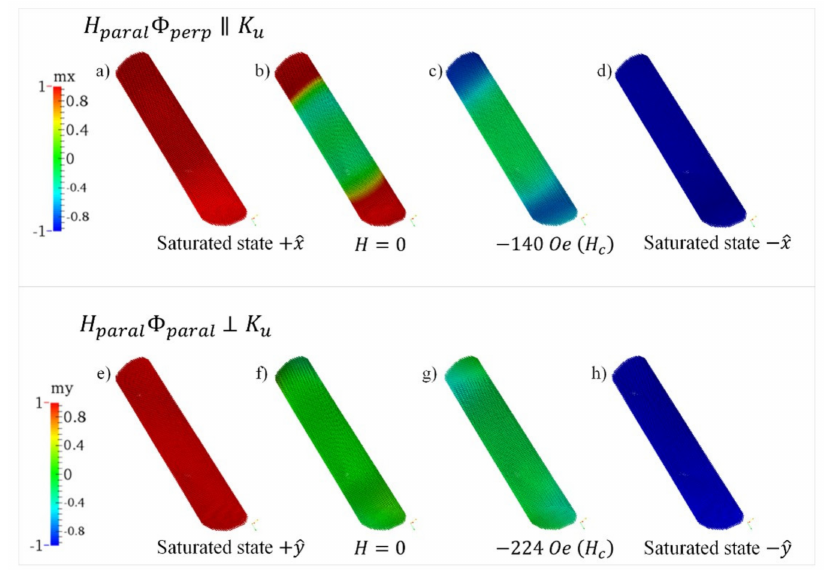
Figure 8. Snapshots of the stable magnetization state corresponding to the NR sample. Top row is for magnetic field applied along the H paral Φ perp direction with different values: ( a ) H = 25,000 Oe (i.e., saturated state in the positive direction), ( b ) H = 0, ( c ) H = − 140 Oe, ( d ) H = − 25,000 Oe (i.e., saturated state in the negative direction). Bottom row is for magnetic field applied along the H paral Φ paral direction with different values: ( e ) H = 25,000 Oe (i.e., saturated state in the positive direction), ( f ) H = 0, ( g ) H = − 224 Oe, ( h ) H = − 25,000 Oe (i.e., saturated state in the negative